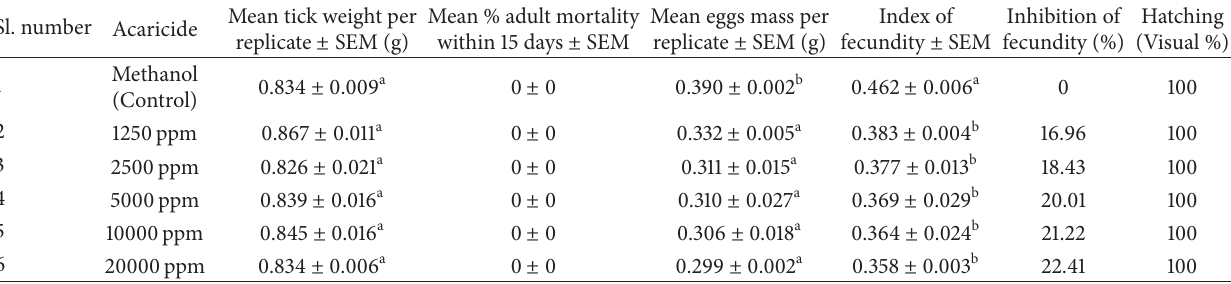
Table 2: Effect of nicotine against R. (B.) annulatus .